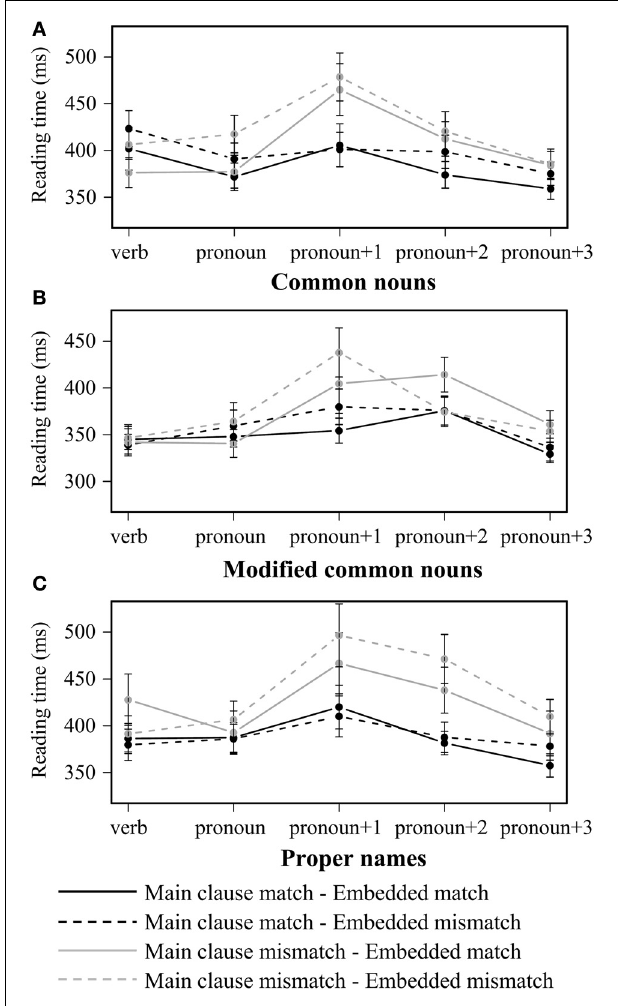
FIGURE 1 | Word-by-word reading times for (A) the common noun, (B) modified common noun and (C) proper name conditions in Experiment 1. Error bars indicate standard error of the participant